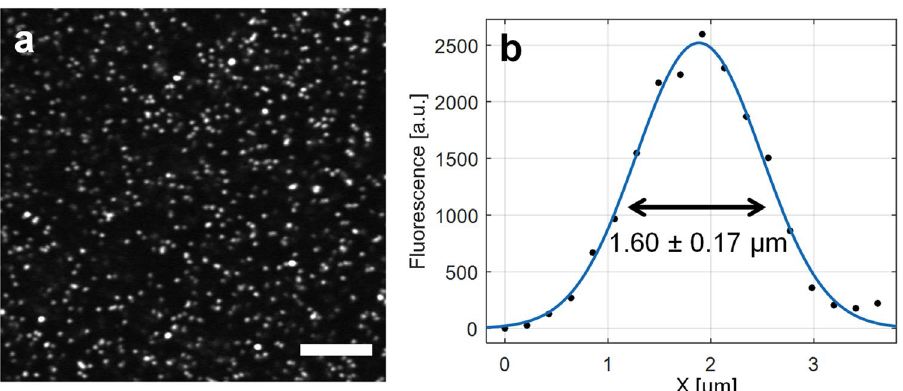
Figure 2. Resolution characterization of the long-distance remote TPM imaging system. ( a ) Two-photon fluorescence images of beads of 1 μ m in diameter. Scale bar: 50 μ m. ( b ) Plot across the diameter of a bead and its Gaussian fitting (blue line) to determine the FWHM